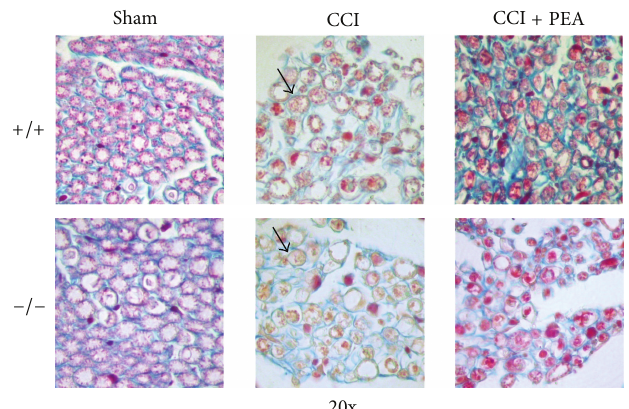
Figure 7: Light micrographs from 5 𝜇 m transverse sections of mouse sciatic nerve stained by Azan-Mallory, comparison between PPAR- 𝛼 +/+